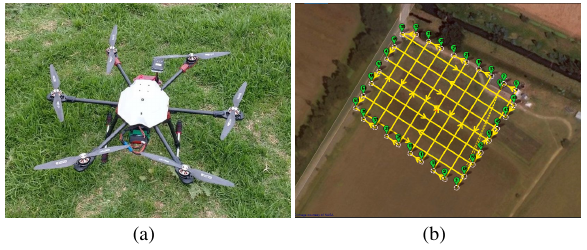
Figure 2. UAV used and flight mission. (a) Hexacopter Tarot 680 PRO; (b) flight mission.